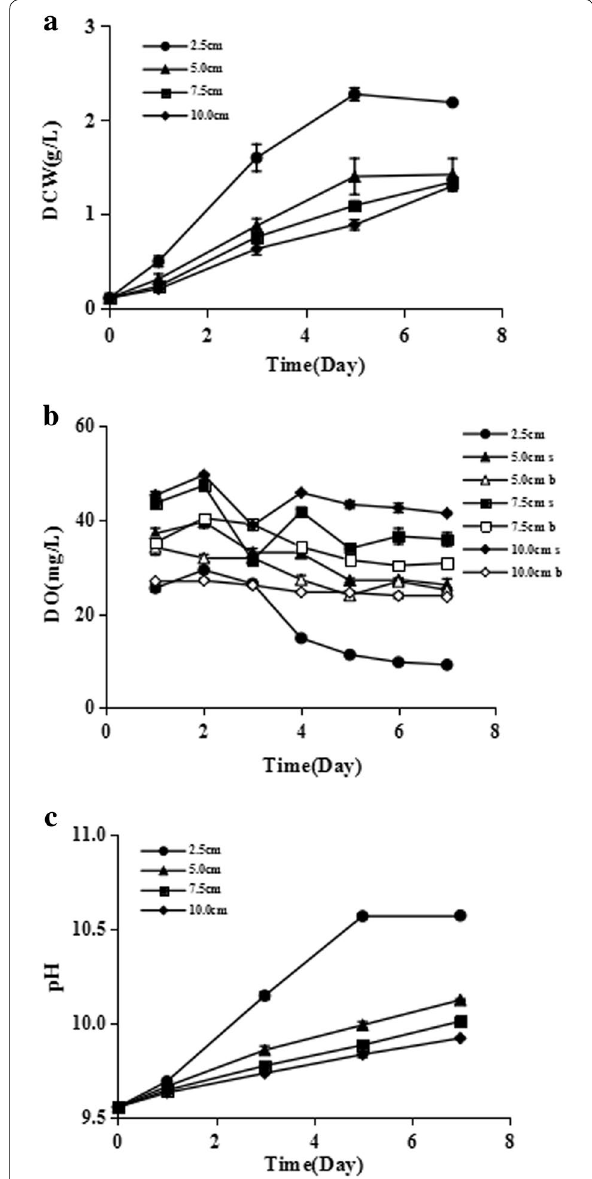
Fig. 3 Culture of Euhalothece sp. ZM001 in horizontal PBR with rocking cycle of 2 s and light intensity of 340 μmol/m 2 /s: a biomass production; b dissolved oxygen (s: surface; b: bottom); c pH